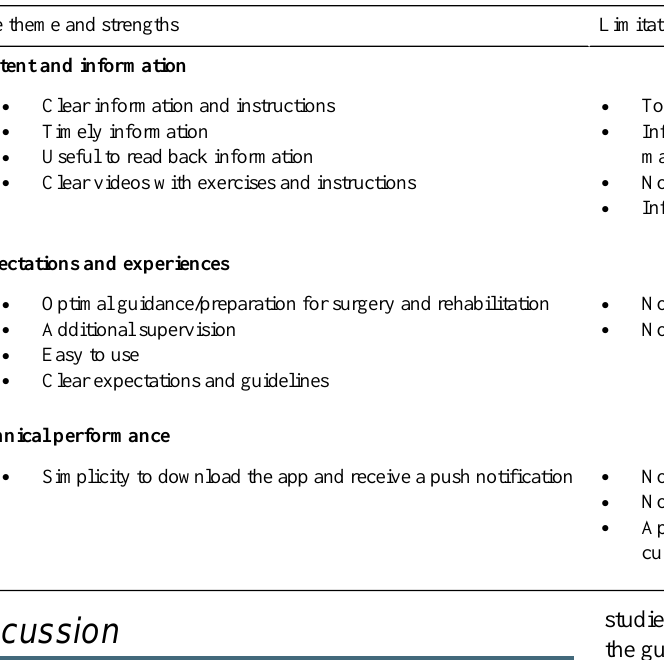
Table 5. Results of the inductive thematic content